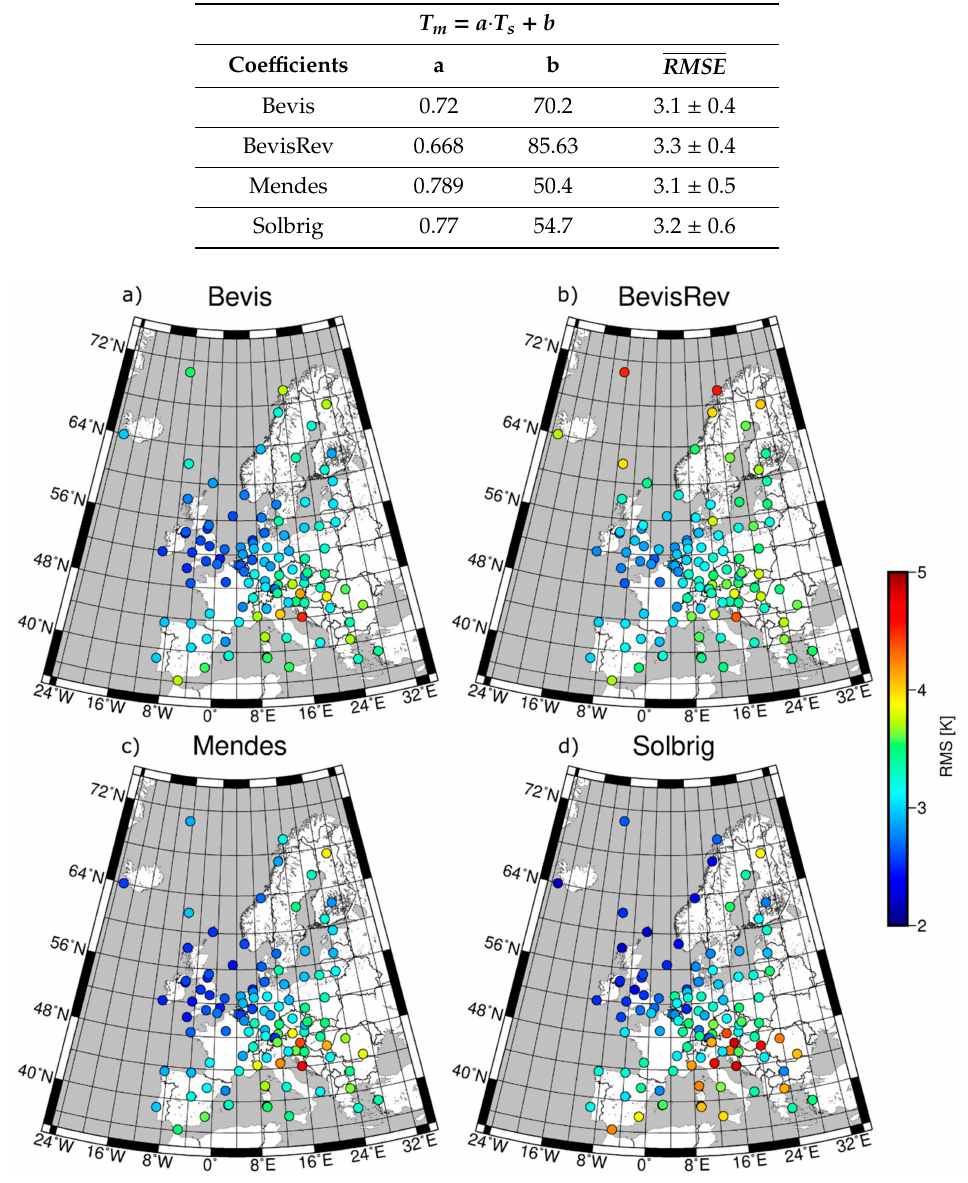
Figure 2. RMSE of di ff erences between direct T m measurements and T m calculated using T s and the following coe ffi cients of linear relationship: Bevis ( a ), BevisRev ( b ), Mendes ( c ), Solbrig ( d ). The dots indicate the location of 109 RS station, while their colors denote RMSE